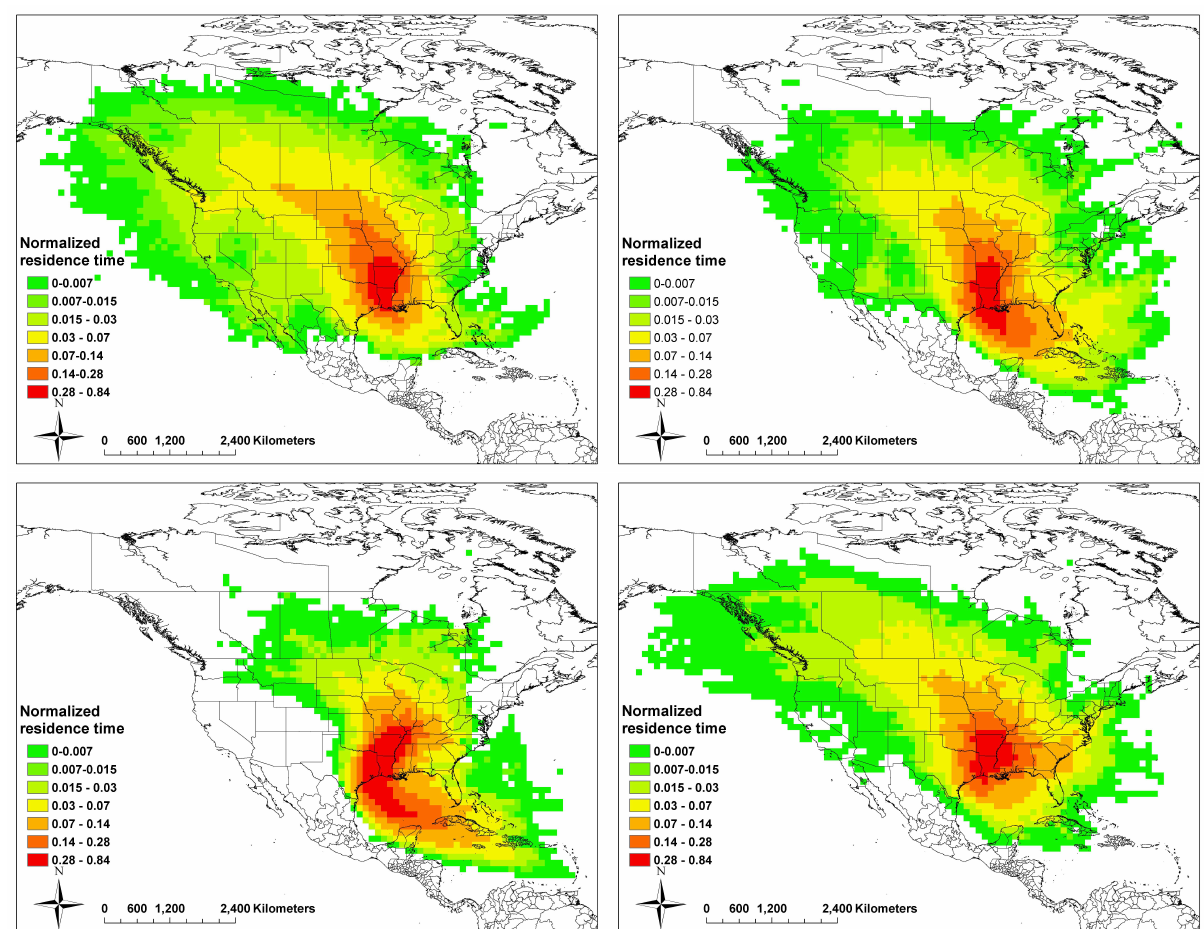
Fig. 6. Percentage of time the air mass parcel is in a horizontal grid cell (0.5 ◦ × 0.5 ◦ ) using backward trajectories at 500m in winter (a) , spring (b) , summer (c) and fall (d)